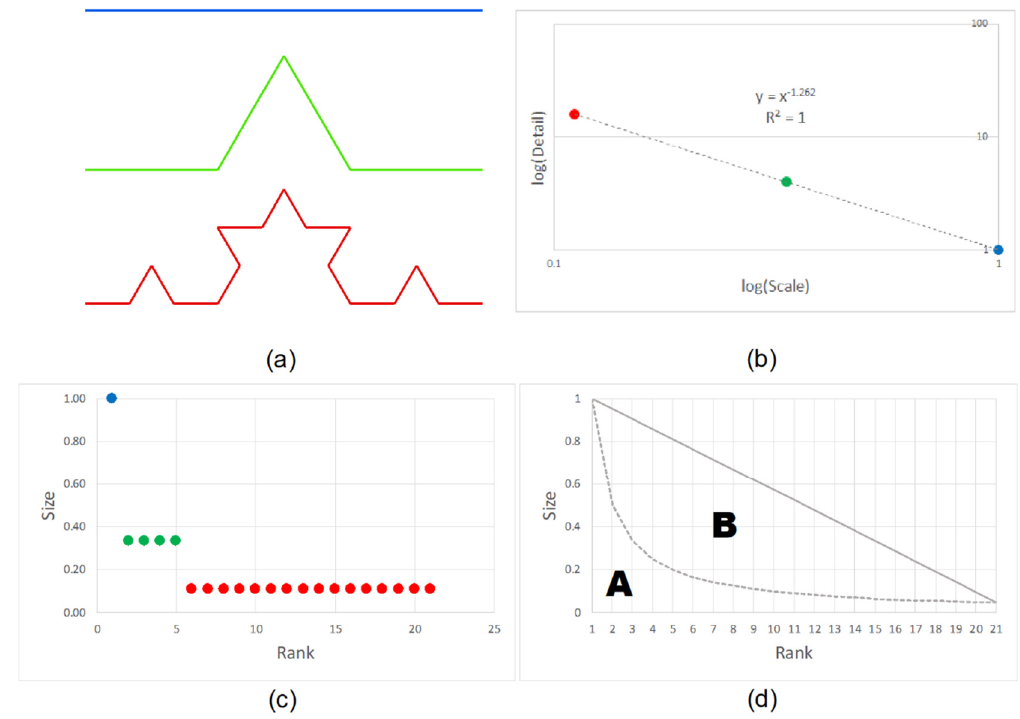
Figure 3. (Color online) The geometric shapes of first three iterations of Koch curve ( a ) and their underlying scaling statistics to illustrate three fractal metrics. Note: ( b ) is the power law relationship between the number of segments and scales; ( c ) ranks all the scales from the largest to the smallest for calculations of ht-index and CRG; ( d ) Two types of areas in the rank-size plot for the calculation of RA